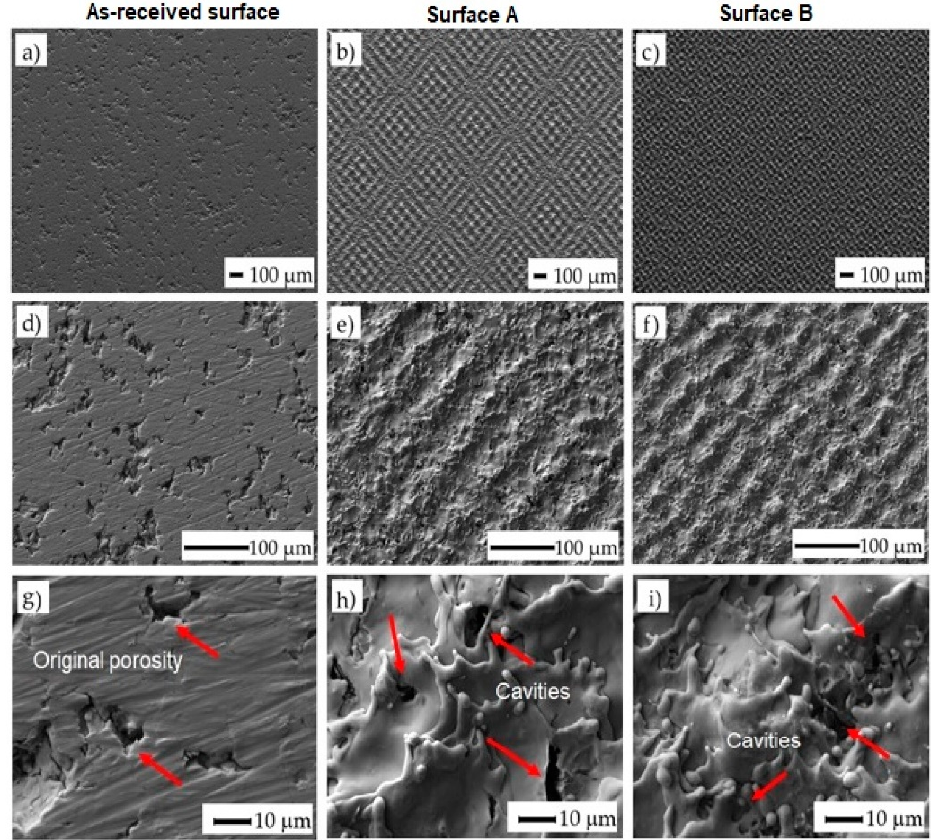
Figure 18. SEM illustrations of treated substrates: ( a ) as-received surface at a resolution of 50; ( b ) surface A at ET of 0.5 mJ and a resolution of 50; ( c ) exterior B at ET of 5 mJ and a resolution of 50; ( d ) surface prior to laser machining at a resolution of 250; ( e ) exterior A at ET of 0.5 mJ and resolution of 250; ( f ) exterior B at ET of 5 mJ; ( g ) SEM scan showing original porosity; while ( h ) showing greater amounts of cavities as a result of corrosive ion invasion and ( i ) showing reduced amount of cavities which restrict the invasion of corrosive ions on the surface of metal. Reprinted with permission from [125]. Copyright 2021 MDPI. Distributed under Creative Commons Attribution-based license (CCBY 4.0.).